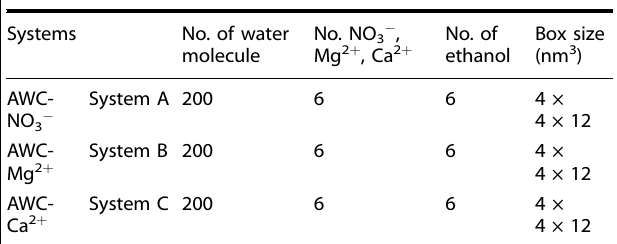
Table 2. Details of the simulation